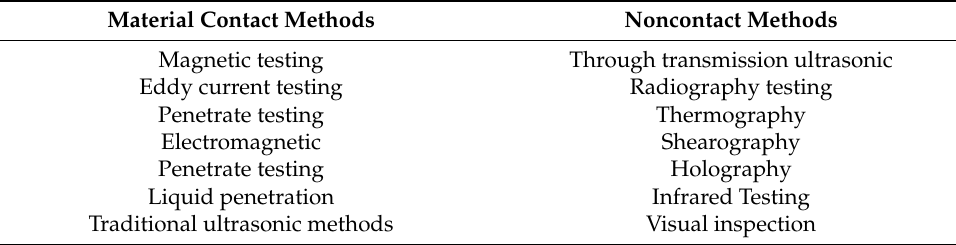
Table 2. A brief classification of contact and noncontact techniques for diagnosis of materials.